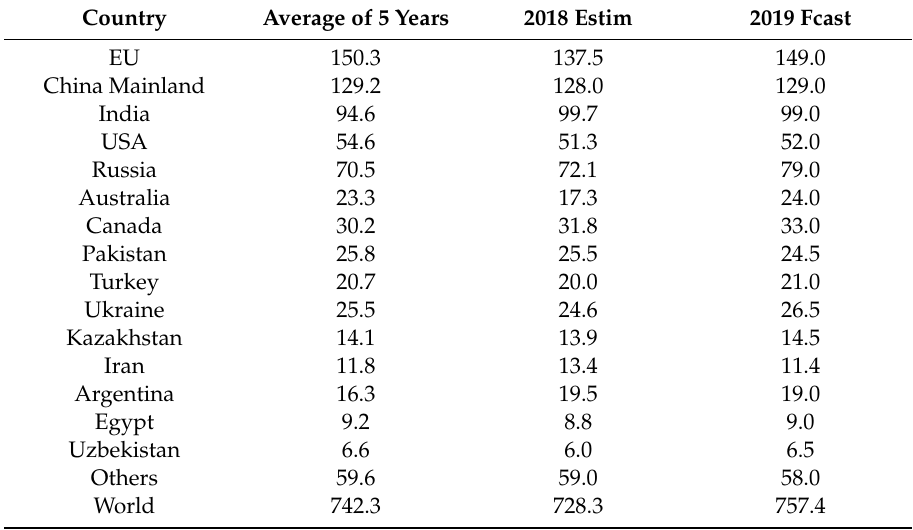
Table 1. Information of the production and forecast of wheat all over the world in a million tons.